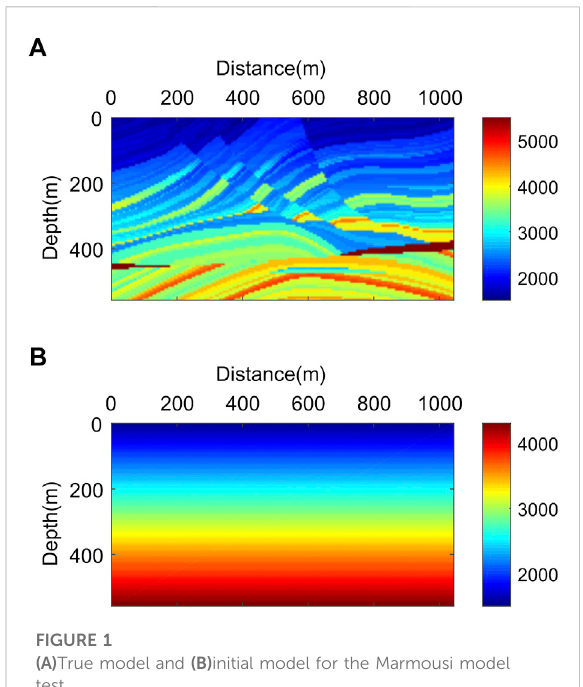
FIGURE 1 (A) True model and (B) initial model for the Marmousi model test.